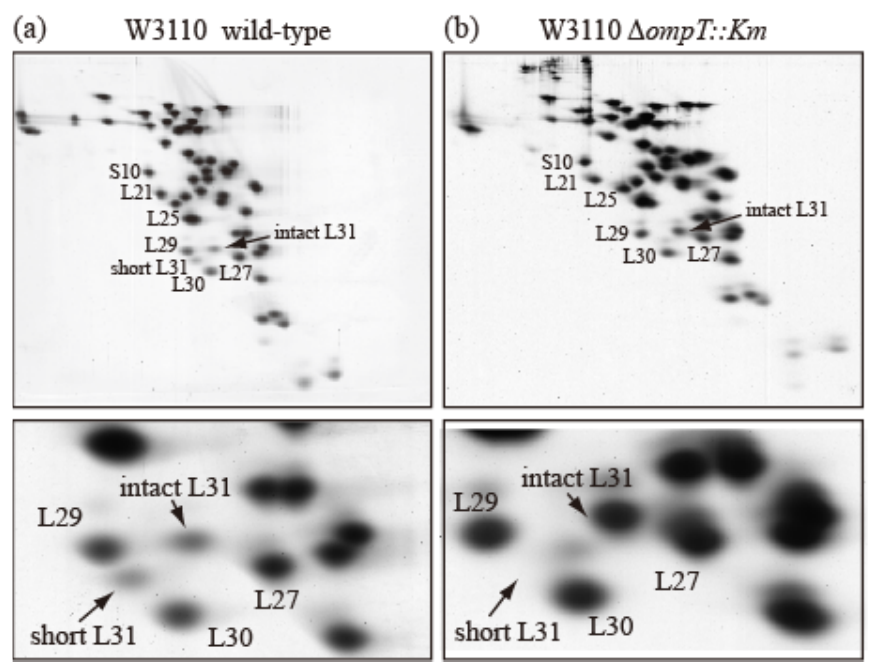
Figure 3. Ribosomes prepared from wild-type E. coli cells contain both intact and short bL31s. ( a ) W3110 wild-type and ( b ) W3110 Δ ompT::Km cells were grown at 37 °C in EP medium and collected in the exponential growth phase (Klett units: 50), and HSRs (high-salt-washed ribosomes) were prepared. HSR proteins were analyzed using RFHR 2D PAGE. Gels were stained with CBB. (Upper) Spots corresponding to r-proteins bS10, bL21, bL25, bL27, bL29, bL30, intact bL31, and short bL31 are indicated. (Lower) An enlarged image of the bL31 spot and surrounding area is shown. In Figure 3, the “b” of r-proteins is omitted.